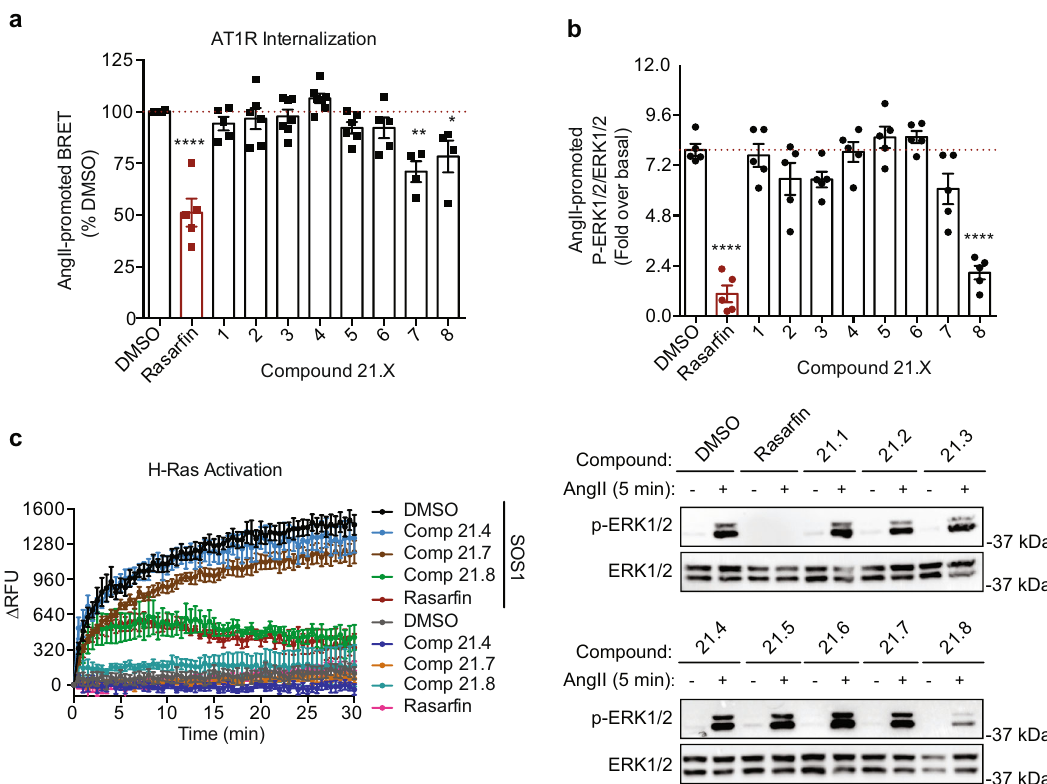
Fig. 8 Functional selectivity of Rasar fi n analogs. a BRET recording of AT1R internalization into endosomes in the absence (DMSO, open black bar) or presence of 50 μ M Rasar fi n (open red bar) or compounds 21 . 1 – 21 . 8 (open black bars). BRET responses were quanti fi ed as AngII-promoted BRET response, percent compared to DMSO (red dotted line). Data are presented as mean values ± SEM, at least n = 4 biologically independent experiments performed in triplicate, * p = 0.0234, ** p = 0.0013, **** p < 0.0001, one-way ANOVA with Dunnett ’ s test. b Quanti fi cation of AT1R-mediated ERK1/2 activation in cells the absence (DMSO, open black bar) or presence of 50 μ M Rasar fi n (open red bar) or compounds 21 . 1 – 21 . 8 (open black bars) and representative western blots. Data are quanti fi ed as p-ERK1/2 over ERK1/2 and normalized as fold over basal. Data are presented as mean values ± SEM, n = 5 biologically independent experiments, **** p < 0.0001, one-way ANOVA with Dunnett ’ s test. c In vitro kinetics of mant-GTP loading into H-Ras. Puri fi ed H-Ras was activated using puri fi ed SOS1 and in the presence of DMSO, Rasar fi n, 21 . 4 , 21 . 7 or 21 . 8 (50 μ M). The relative fl uorescence unit (RFU) was measured every 30 s for 30 min and quanti fi ed as the delta RFU (RFU post-addition minus the 5 averaged RFU pre-addition, per condition). Data are presented as mean values ± SEM, n = 3 independent experiments. Source data are provided as a Source Data fi